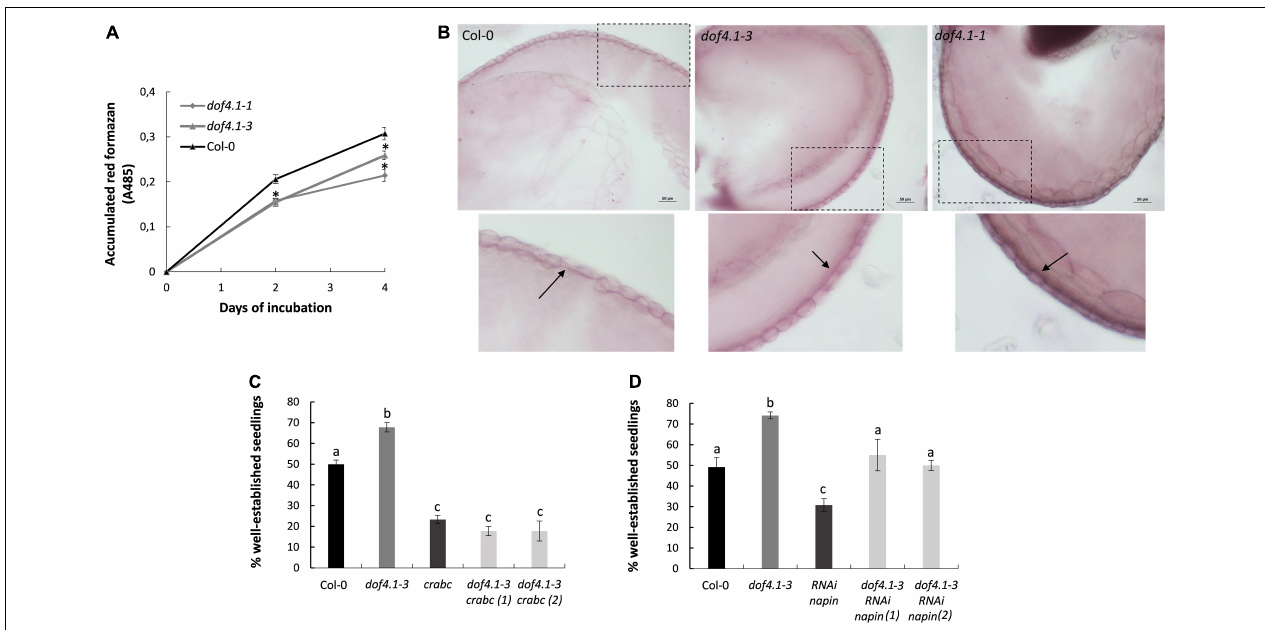
FIGURE 3 | dof4.1 mutants present reduced seed permeability and dof4.1-3 increased SSPs content determine its higher longevity. (A) Seed permeability of dof4.1 mutant. Quantitative time course of formazan accumulation in Col-0, dof4.1-1, and dof4.1-3 seeds. Wild type (Col-0) and mutant seeds were incubated during 2 or 4 days in 1% tetrazolium at 30 ◦ C and then formazan was extracted and quantified. Data (absorbance at 485 nM) are the mean and standard error of three biological replicates. Asterisks indicate significant differences with WT ( P < 0.05) between samples in two-tailed Student’s t -test. (B) Sudan Red 7B staining of the subepidermal layer of the seed coat in wild type (Col-0), dof4.1-3 and dof4.1-1 dry seeds. Scale bars correspond to 50 µ M. Lower panels amplify the indicated area to show a detail of the staining. Arrows point to the suberin layer Accelerating Aging Treatment over a quadruple mutant dof4.1-3 cra crb crc (C) and a transgenic RNAi line for napins in dof4.1-3 background (D) . Seeds were imbibed in water and incubated at 40 ◦ C for 32 h. Percentage of established seedlings was recorded after 9 days growing on MS media. Different letters indicate significant differences with WT ( P < 0.05) between samples in two-tailed Student’s t -test. Col-0, Columbia 0. crabc, cra crb crc. RNAi napin: transgenic line silenced in napins by RNA interference. Data are the mean and standard error of three biological